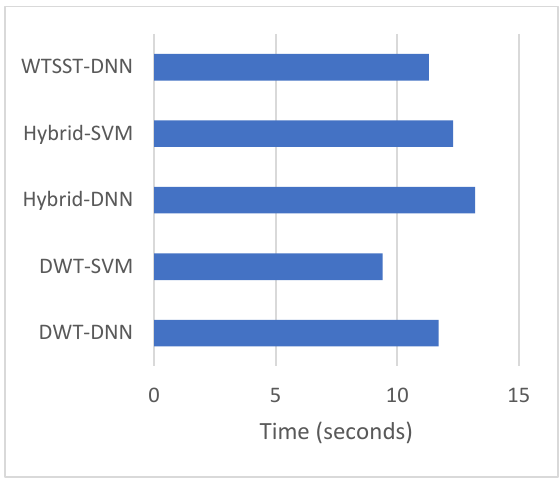
Figure 12. Execution time of the proposed models.